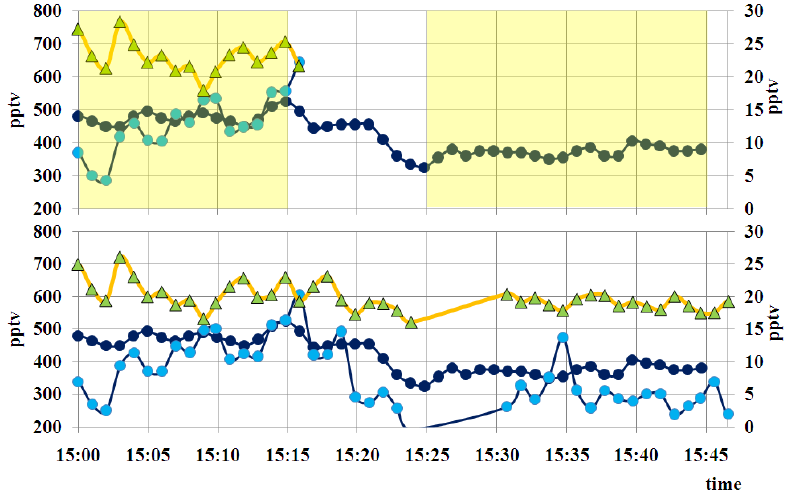
Fig. 13. [HCHO] measured on board the D-Falcon (dark blue circles) and modeled (blue) for the intercomparison exercise. The model data are constrained to j (NO 2 ) measured on board the BAe-146 (top) or to j (NO 2 ) measured on board the D-Falcon scaled to the j (NO 2 ) -BAe values measured at 697hPa (botom) as in Figs. 10 and 11. The corresponding [HO 2 ] model data in ppt are also included for comparison (right y -axis). The periods of the intercomparison are highlighted in the top figure in yellow.